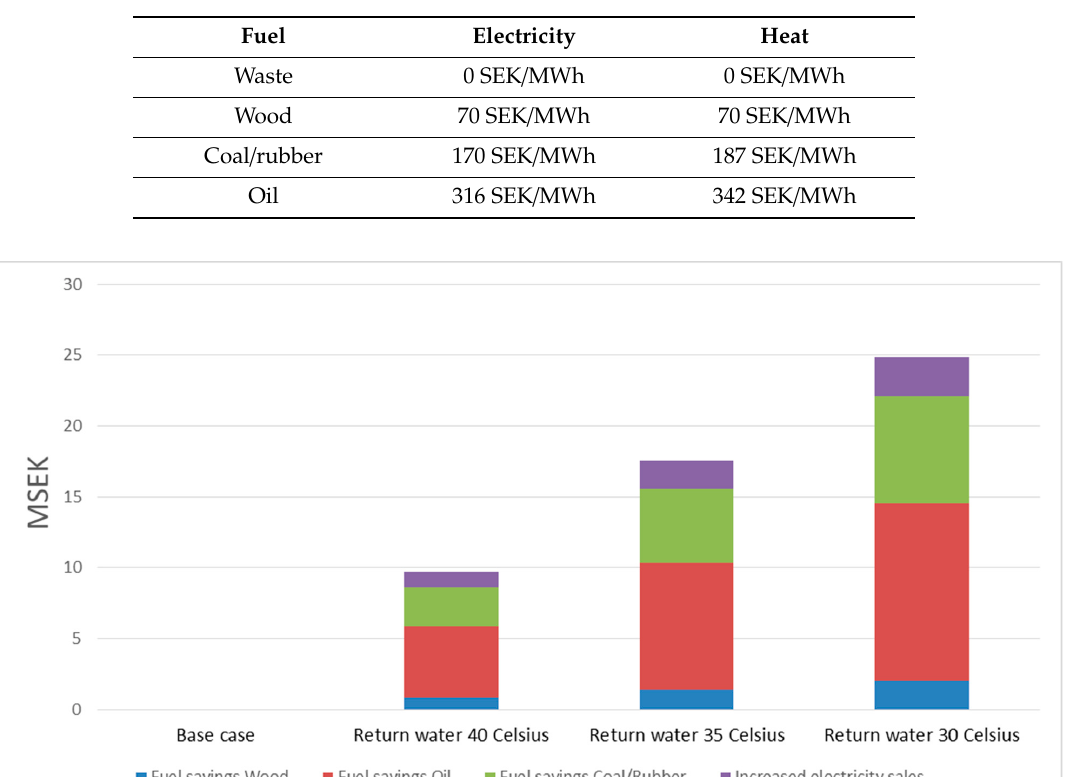
Figure 12. Modelled changes in GHG emissions for the examined cases with three different system boundaries.